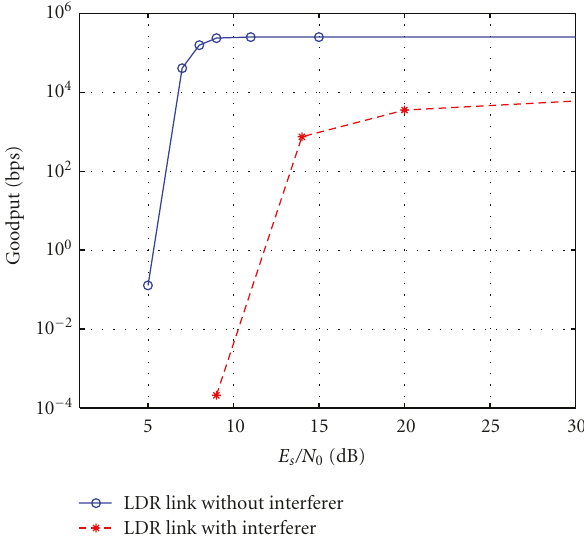
Figure 8: LDR link goodput without and with interference placed at 10cm distance from the LDR receiver. The distance between the interferer and the intended receiver is set to 10